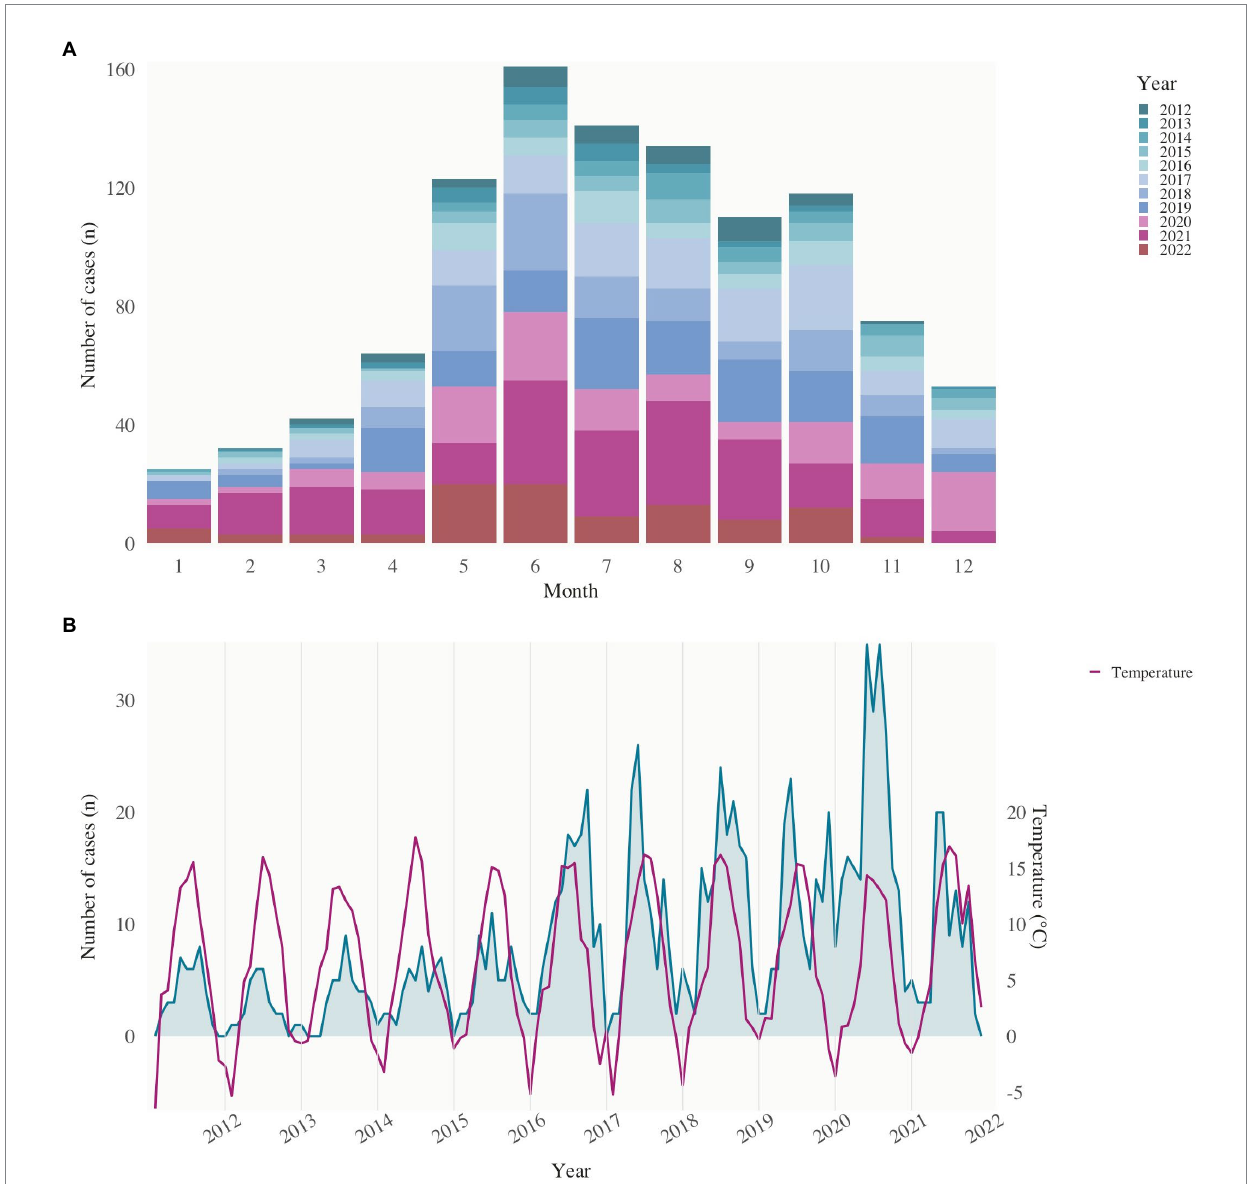
FIGURE 5 Seasonality of reported human tularemia cases. (A) Notified cases of tularemia (stacked bars) by month of notification, Switzerland, 2012–2022. (B) Notified cases of tularemia from 2012 to 2022 and mean temperature ( ° C, second y -axis) in